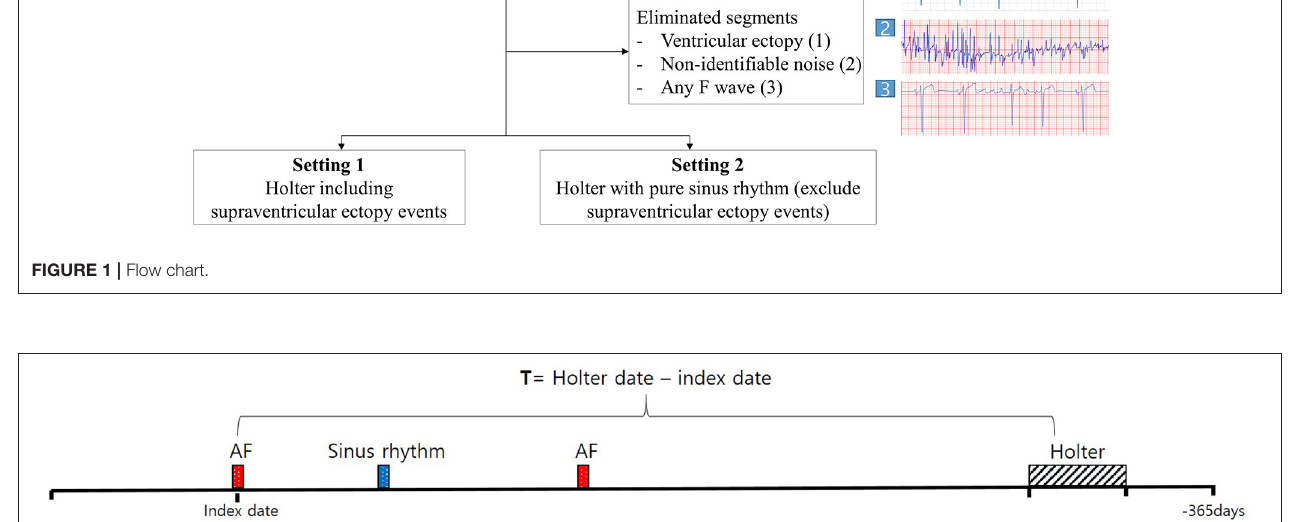
FIGURE 2 | Timeframe of index date and Holter